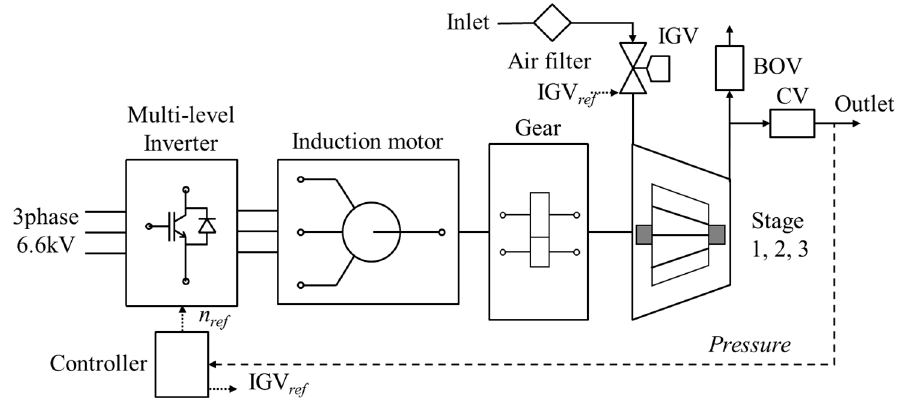
Figure 1. Block diagram of a turbo air centrifugal compressor system (TACCS). IGV: inlet guide vane; BOV: blow of valve; CV: control valve.